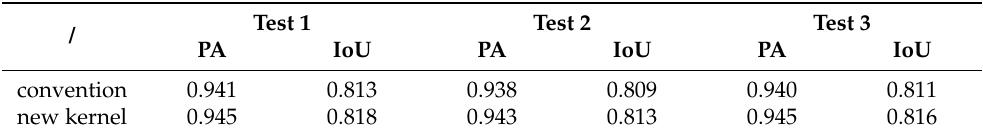
Table 3. Performances of different convolution kernels.